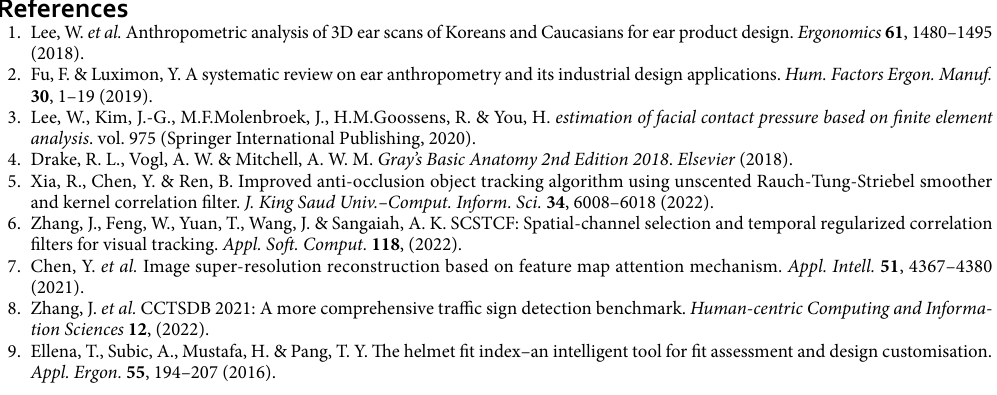
Table 6. Coefficient of spearman correlation for mean value of three regions of ear. **Correlation is significant at the 0.01 level. *Correlation is significant at the 0.05 level.